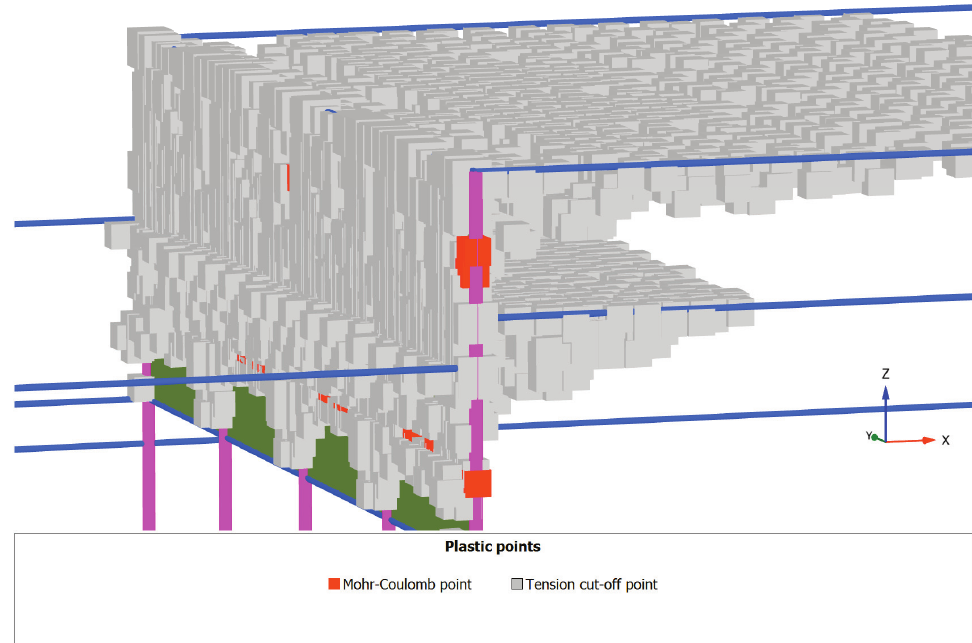
Fig. 8. Plastic points and tension cut-off points in preliminary